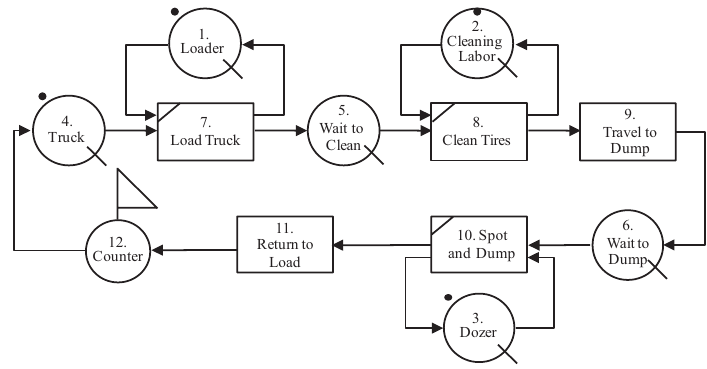
Fig. 2. Earthmoving operation model used as case